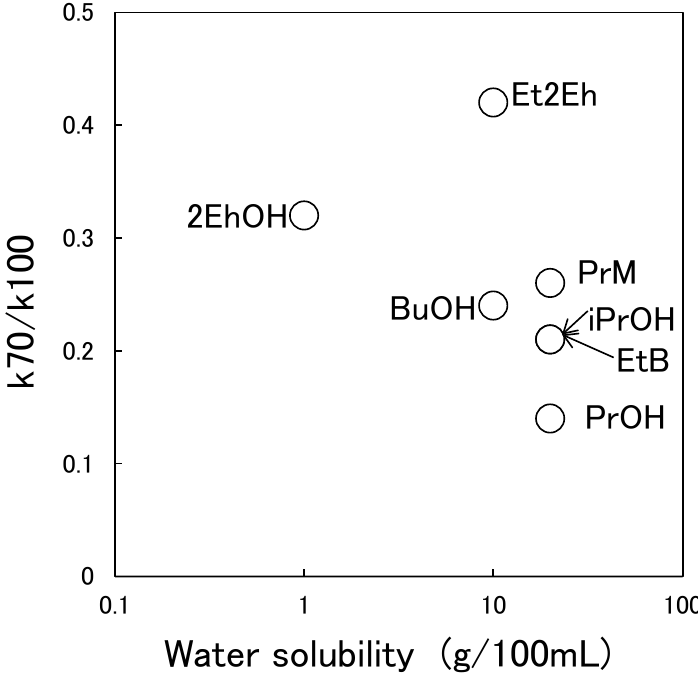
Figure 7. The k70 and k100 values for paint samples with different solvent compositions. Figure 8 shows the relationship between the water solubility of the organic solvent and k70/k100 values. Solvents with water solubility levels exceeding 10 g/100 mL are plotted as 20 g/100 mL in Figure 8 for convenience. As shown in Figure 8, no correlation between water solubility and the k70/k100 exists. Figure 9 shows the relationship between the boiling point of the organic solvent and k70/k100 values. The k70/k100 values increase with the increasing boiling point; in other words, the switchability decreases.